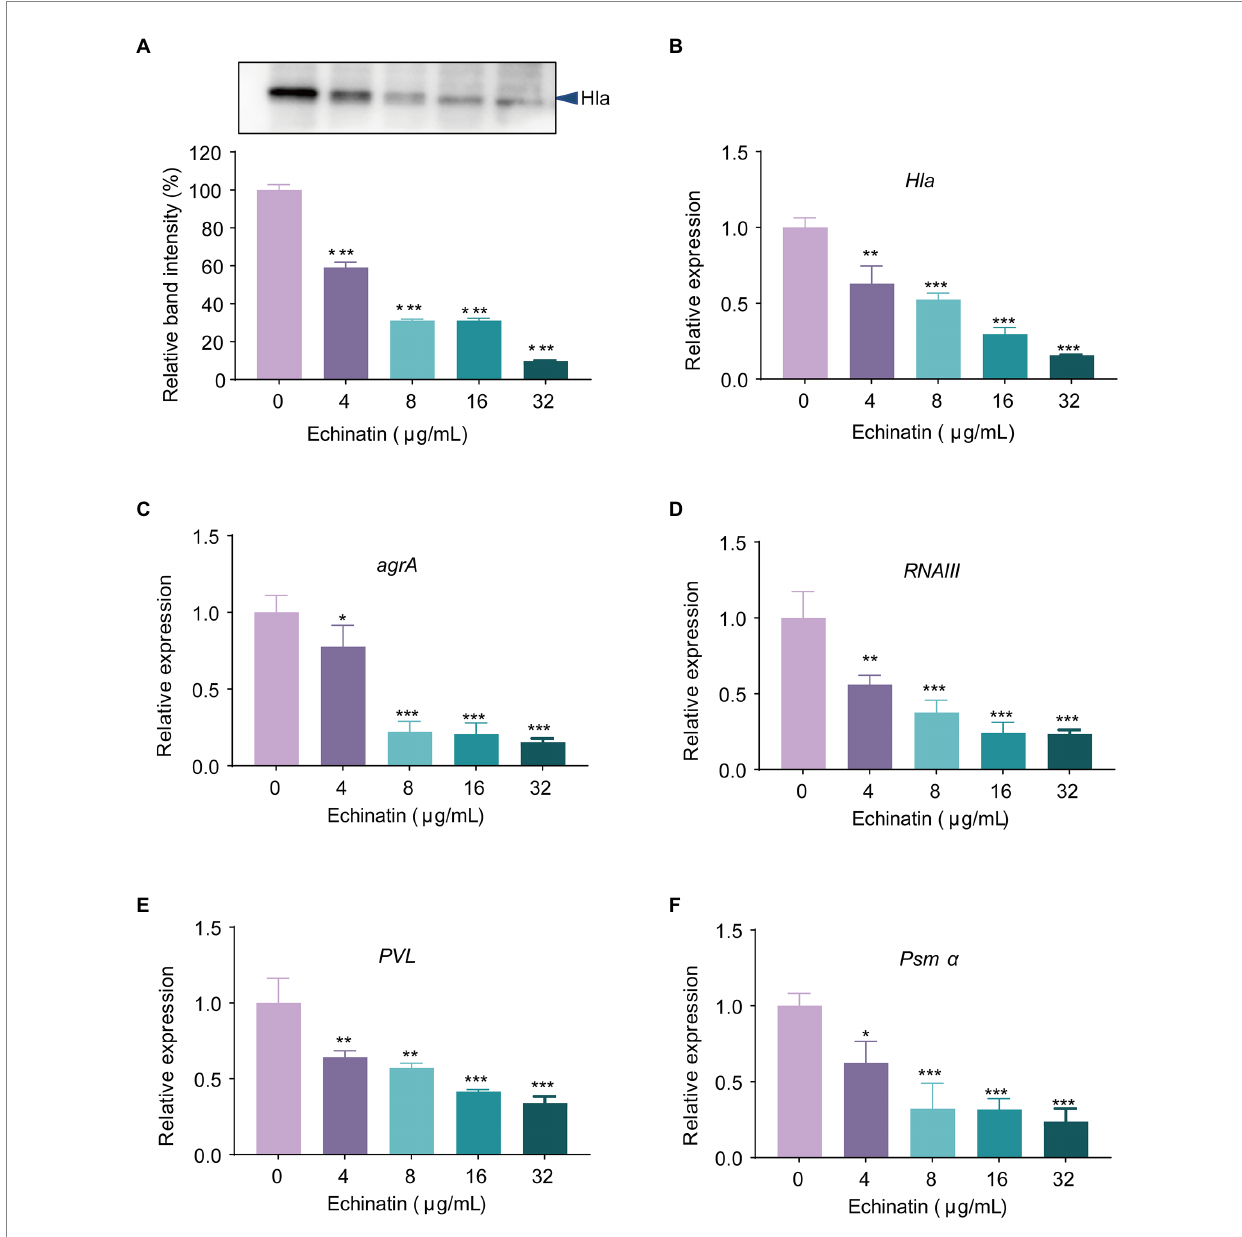
FIGURE 3 Echinatin significantly decreases the expression of Hla and Agr system regulatory-related genes. (A) Expression levels of Hla in S. aureus USA300 after treatment with different concentrations of echinatin (0 to 32 μ g/mL) were determined by western blot analysis. Transcription levels of (B) hla , (C) agrA , (D) RNAIII , (E) pvl , and (F) psm α were determined in S. aureus USA300 treated or untreated with echinatin, and 16S RNA was used as the internal reference gene. Experiments were performed in triplicate. * p < 0.05, ** p < 0.01, and *** p < 0.001 compared to